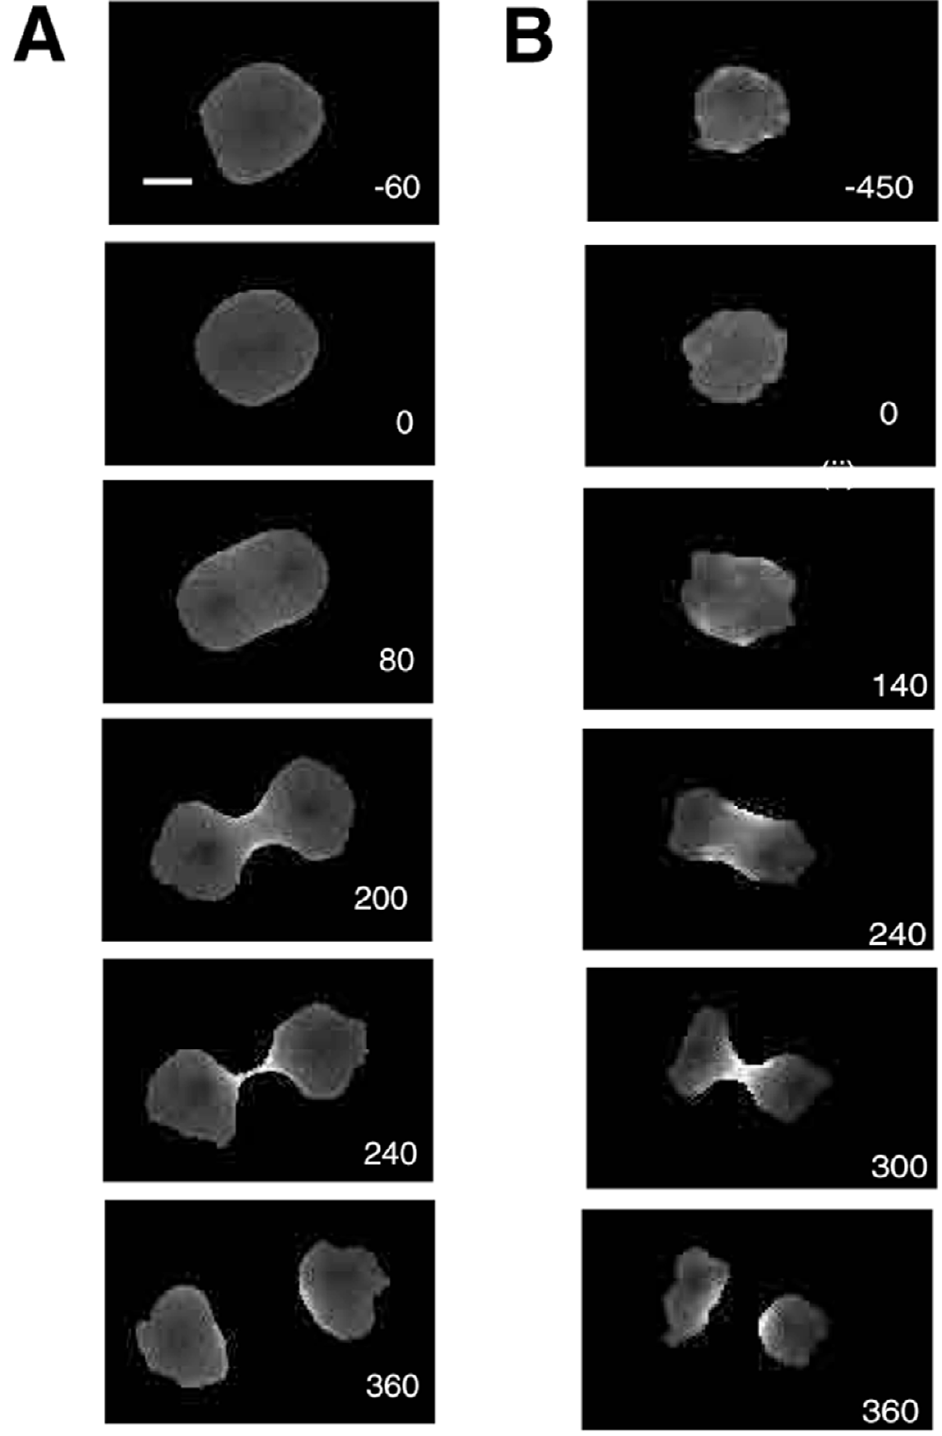
Figure 2 A. A time series of ratio images of a wild type GFP-myosin-II expressing cell going through cytokinesis. The numbers indicate seconds with 0 defined as the point of nuclear division. B. A time series of ratio images of a 3 × Ala GFP-myosin-II expressing cell going through cytokinesis. Bar, 5 µ